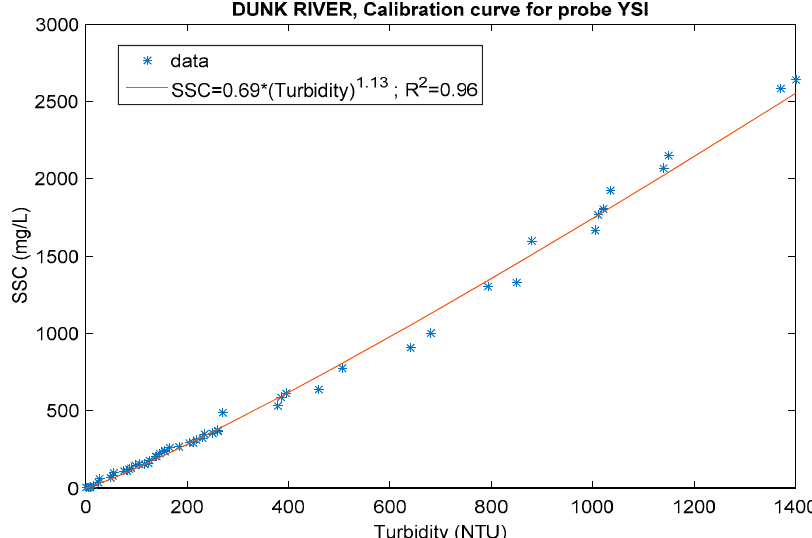
Figure 2. Suspended sediment calibration curve for a turbidity probe YSI 6136.